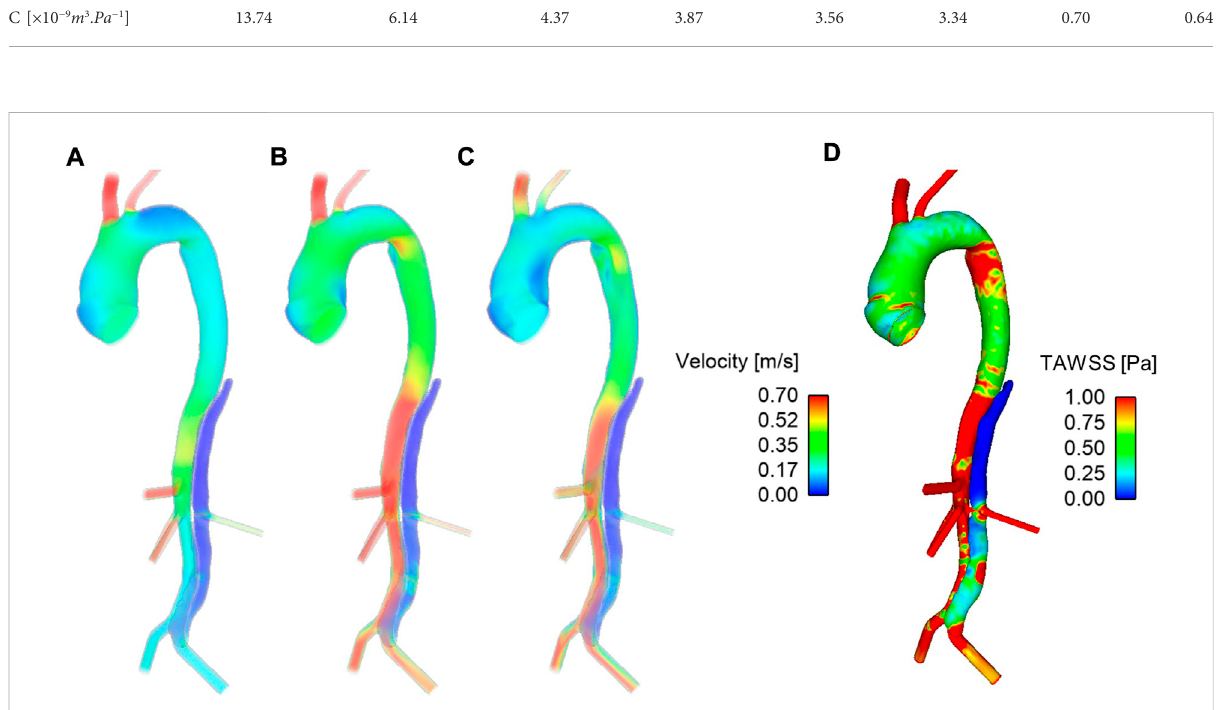
FIGURE 3 Velocity fi elds at (A) mid-systolic acceleration, (B) peak systole, and (C) mid-systolic deceleration during the second cardiac cycle of the simulation. (D) Time-averaged wall shear stress (TAWSS) contours after the second cardiac cycle of the